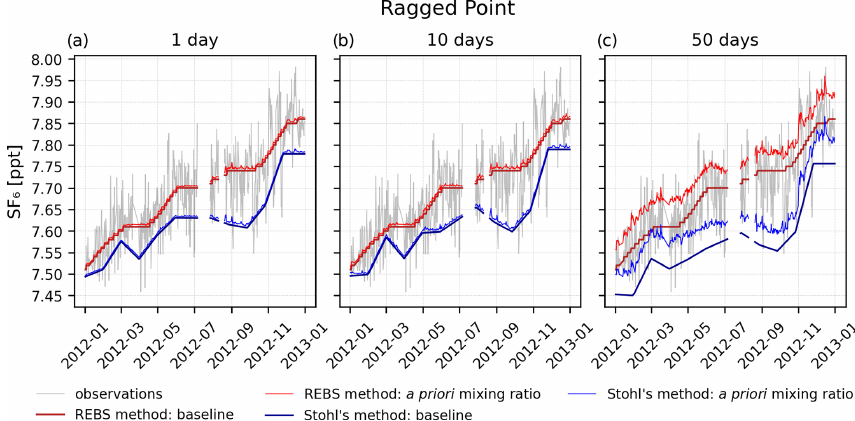
Figure 5. Baseline and a priori SF 6 mixing ratios determined by the REBS method and Stohl’s method at the Ragged Point observation station for backward simulation times of 1d ( panel a) , 10d (b) , and 50d (c)